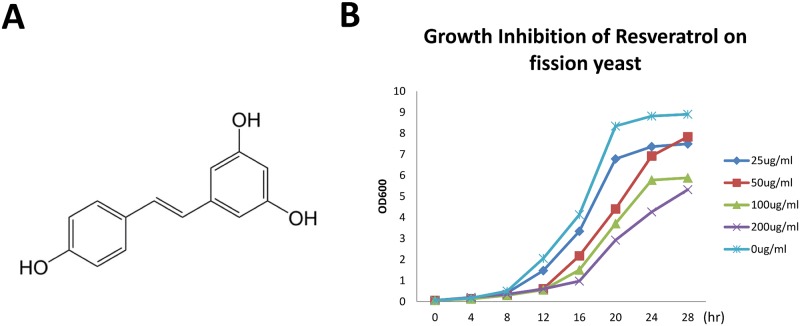
Resveratrol can inhibit the proliferation of fission yeast.(A) The structural formula of resveratrol. (B) Yeast growth inhibition curve under different doses of resveratrol (0, 25, 50, 100, and 200 μg/ml).